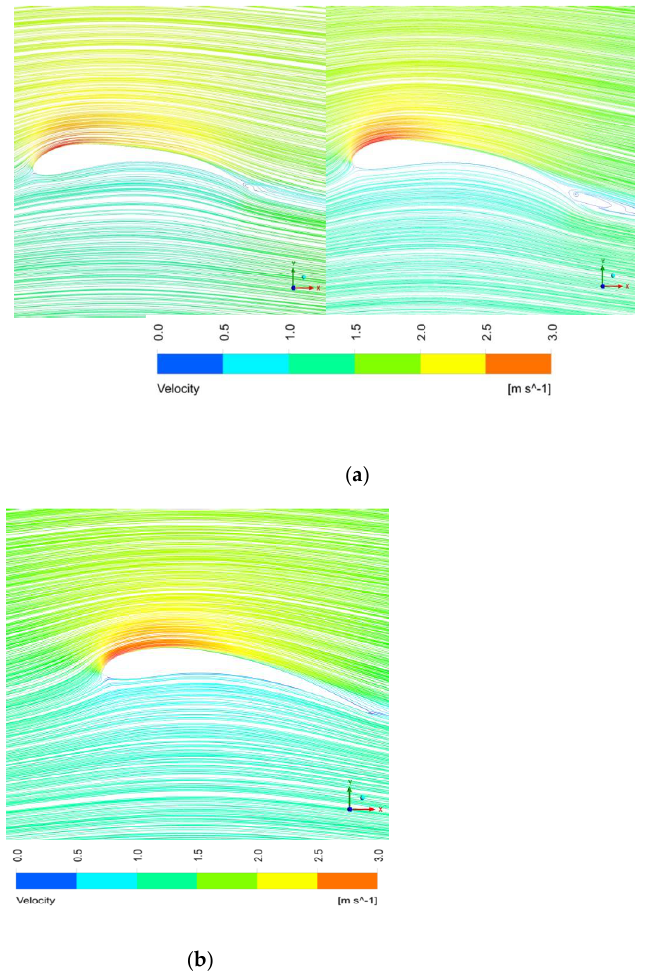
Figure 12. Streamline diagrams of the long − eared owl airfoil. ( a ) Streamline diagram of the initial airfoil velocity of the long − eared owl airfoil (angle of attack 5 ◦ on the left, 10 ◦ on the right); ( b ) Streamline diagram of the optimized airfoil velocity of the long − eared owl airfoil (angle of attack 10 ◦ ).